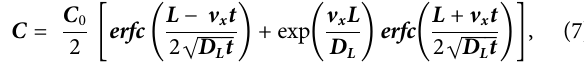
plotted versus device measurements. A trendline with an equation was de fi ned ( Figure 6 ). These equations were used to convert the device measurements to the PE concentrations. The samples were collected in tubes with a cap to avoid the evaporation of the ethanol. PE concentrations of the samples were measured after the end of the experiment.